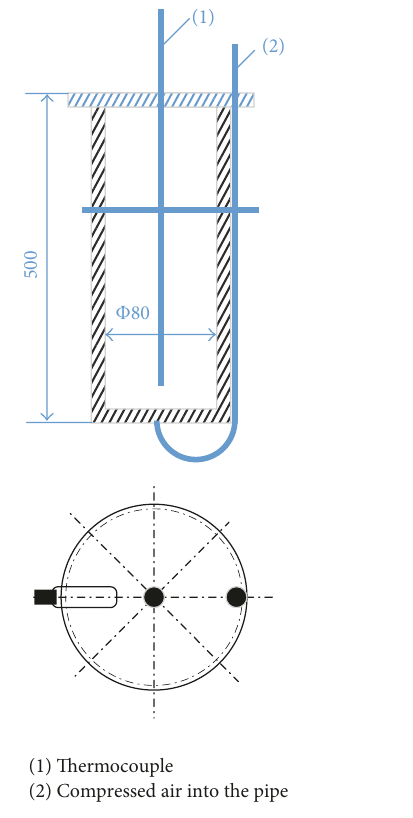
Figure 3: Burst temperature measuring device.